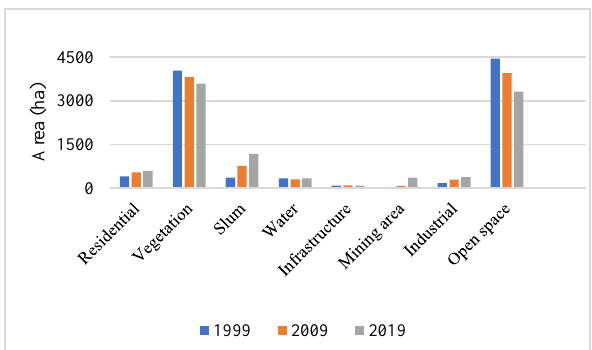
Figure 3. Land use changes in Darkhan city